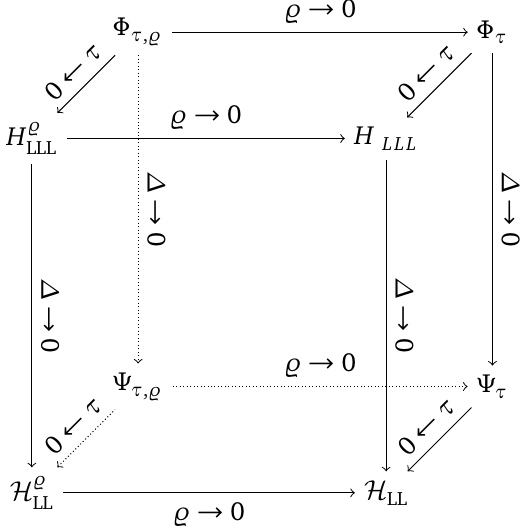
(upper-left , (cid:37)